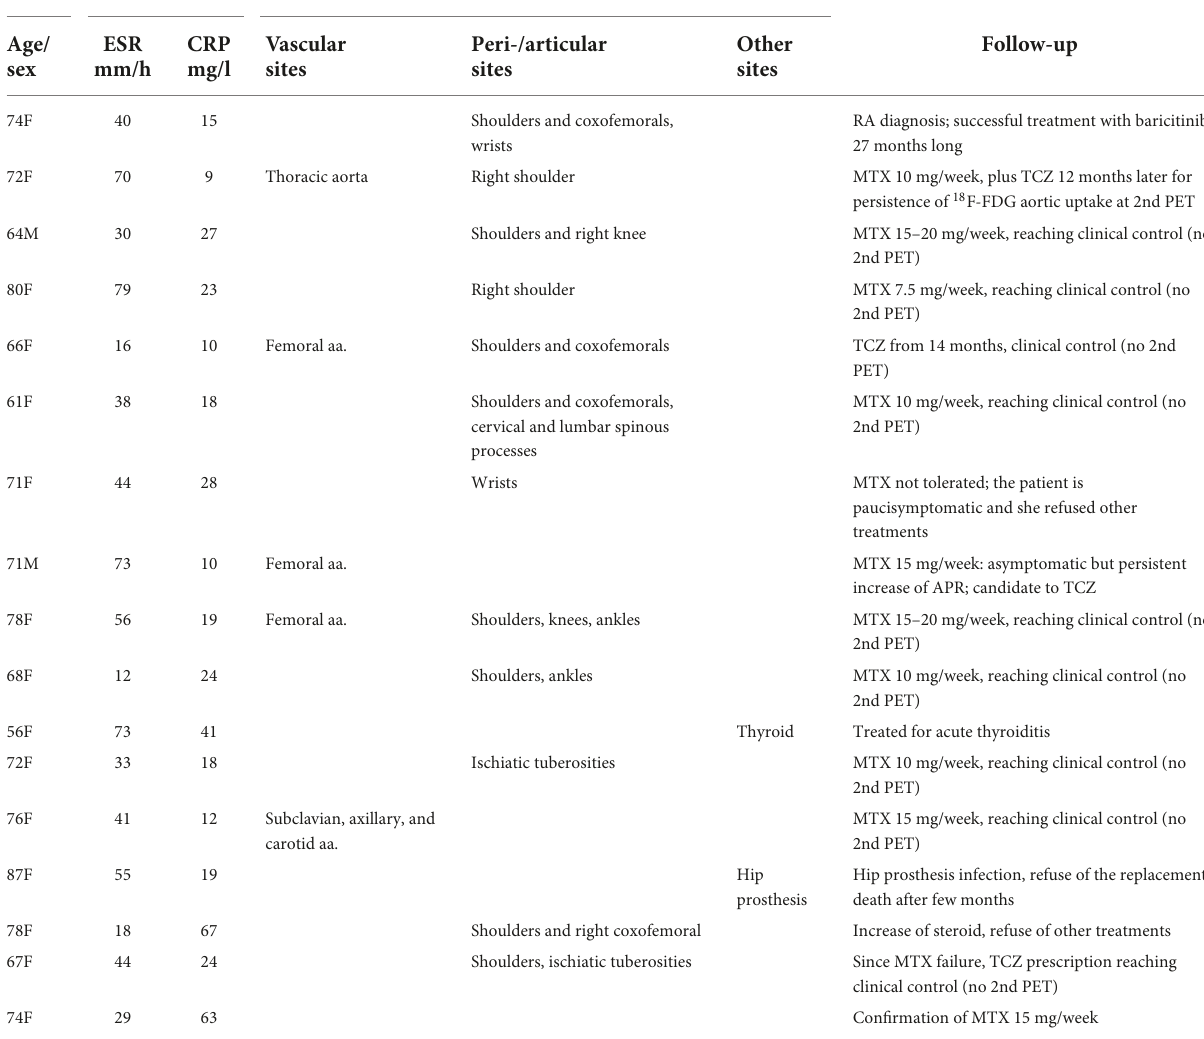
TABLE 1 The polymyalgia rheumatica (PMR) patients (Pts) with increased acute phase reactants (APR), besides steroid therapy, who underwent total body 18F-fluorodeoxyglucose positron emission tomography-computed tomography ( 18 F-FDG-PET/CT).